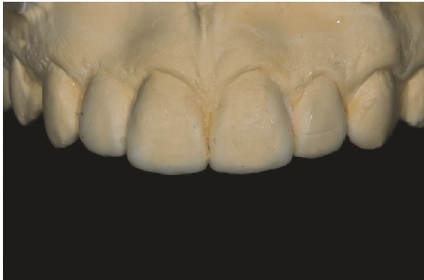
Figure 3: Model of diagnostic wax-up. Note the more defined and triangular contour of the buccal proximal